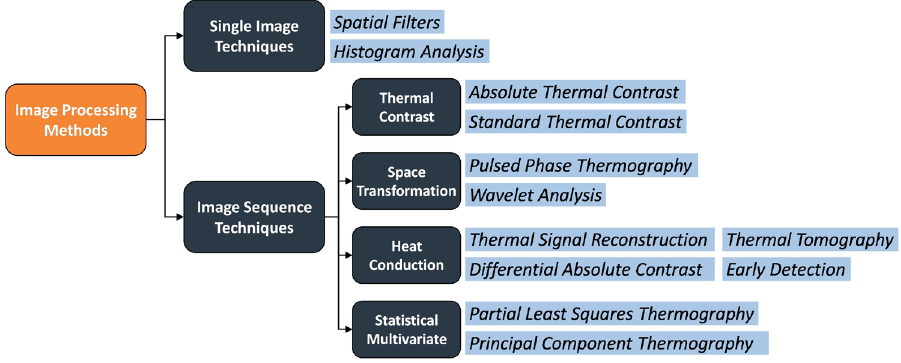
Figure 1. Most widely used image processing algorithms in TNDT 3